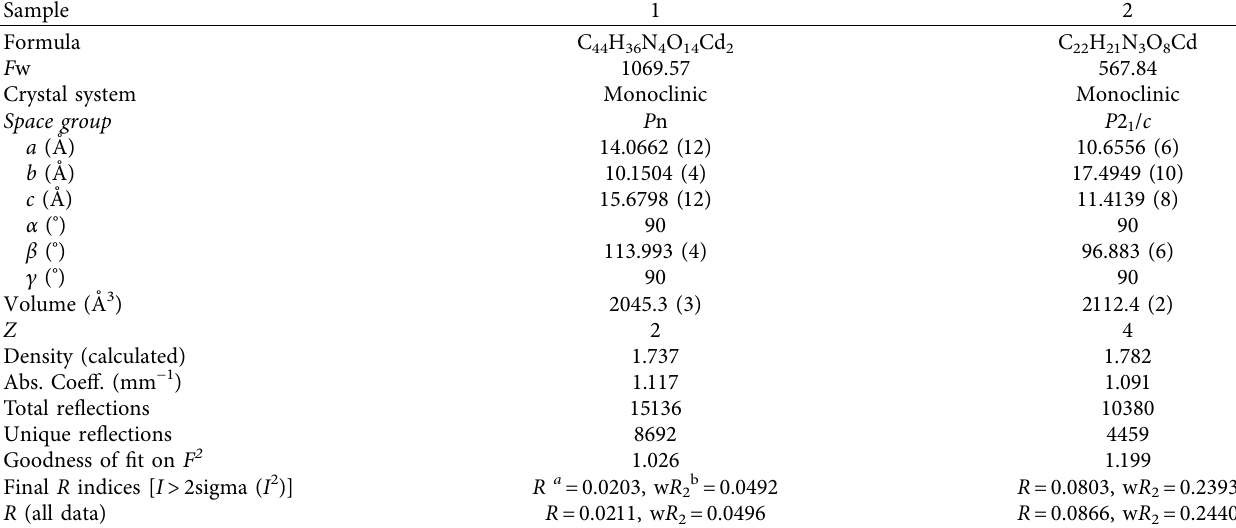
Table 1: The compounds’ crystallographic data along with architectural